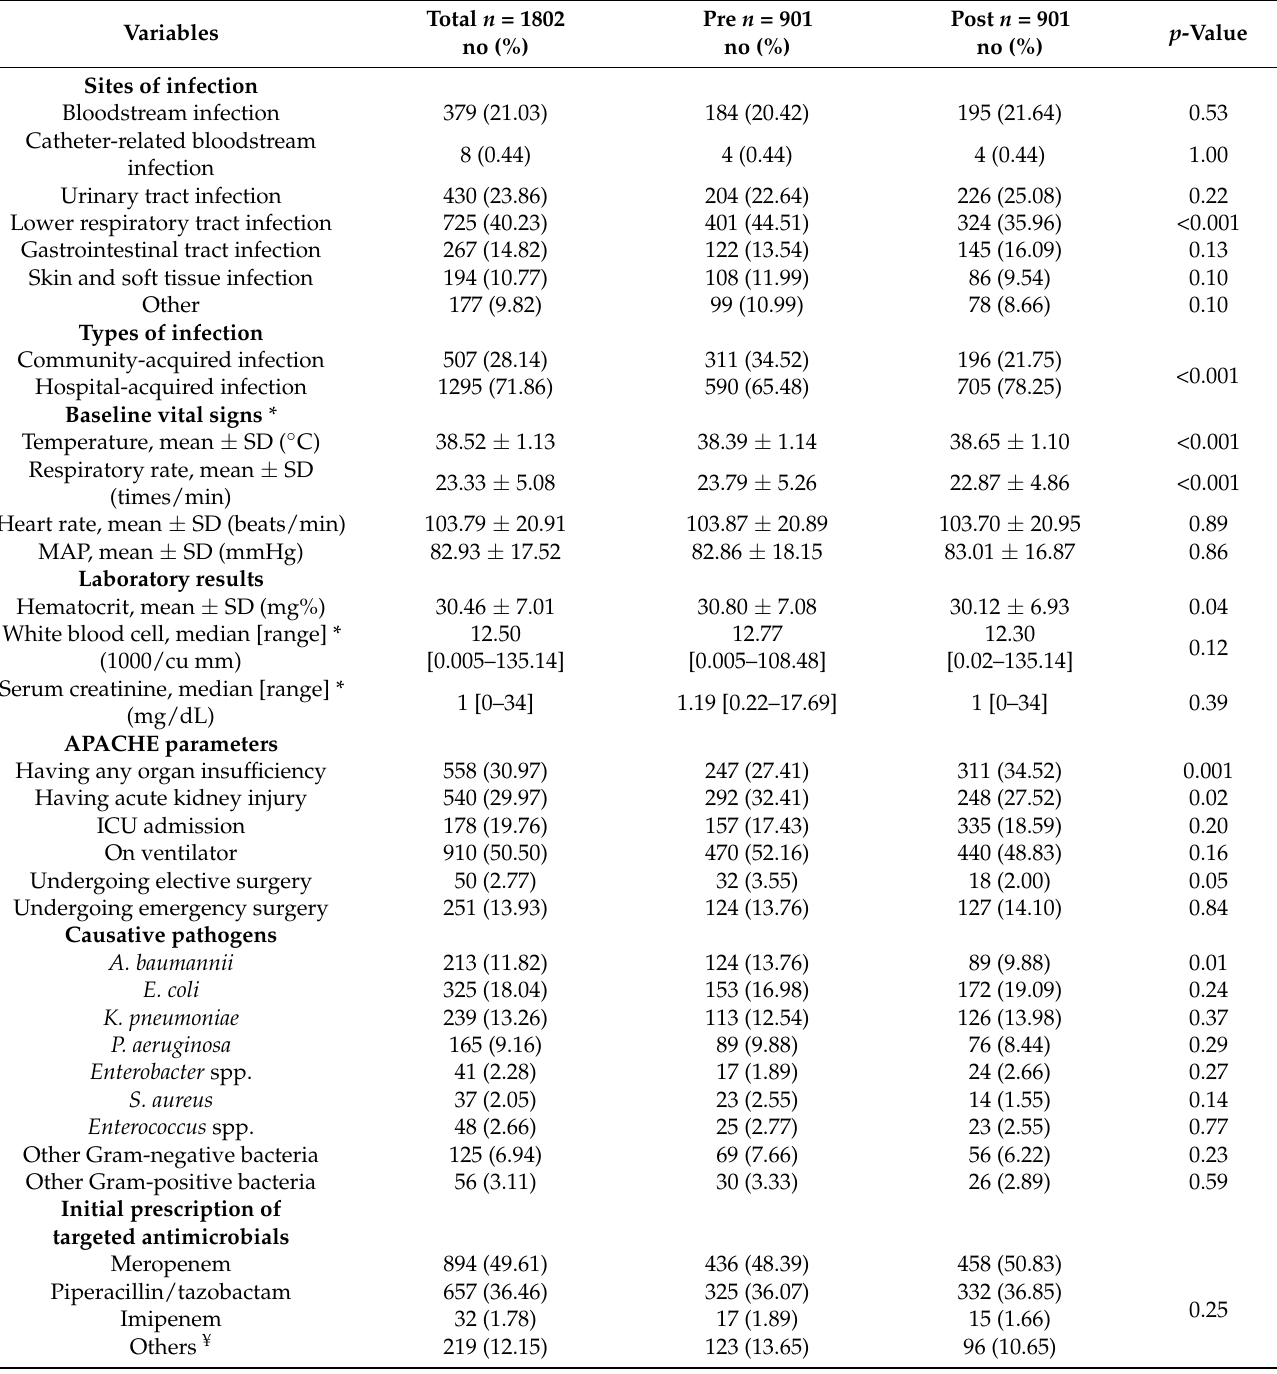
Table 2. Comparison of infection characteristics and antimicrobial therapy of patients in the pre- and post-implementation